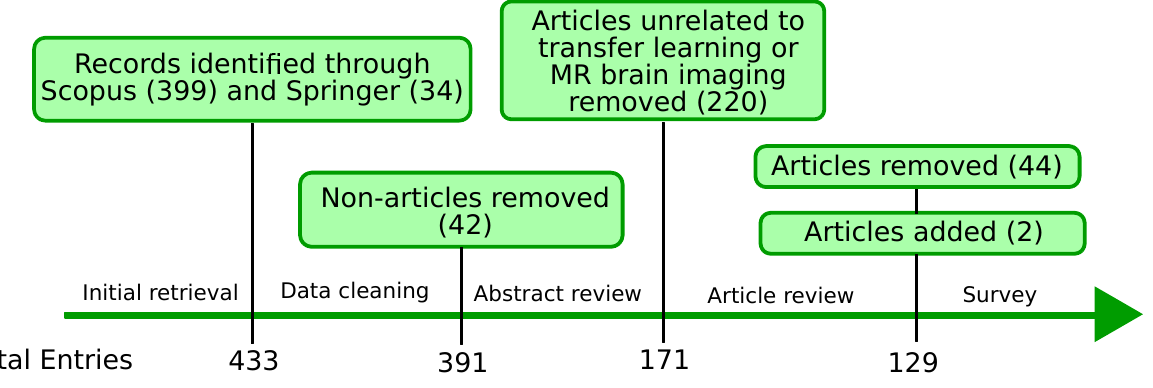
Figure 1. Flowchart of the screening process.